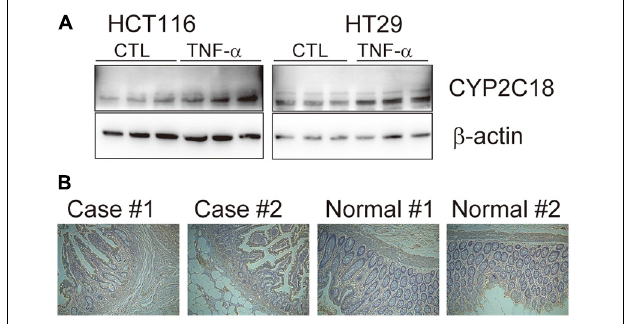
FIGURE 7 | The expression level of CYP2C18 was upregulated in colorectal cancer cell lines and UC-affected cases. (A) The expression level of CYP2C18 was highly increased after TNF- α stimulation. (B) Representative images of immunohistochemistry staining of CYP2C18 in UC affected cases and normal individuals. Scale bar: 100 µ